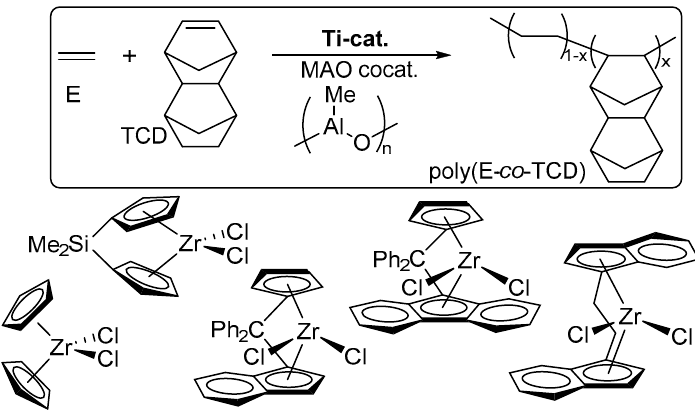
Table 2. Copolymerization of ethylene with tetracyclododecene (TCD) by Cp’TiCl 2 (N=C t Bu 2 ) (Cp’ = Cp ( 7 ), t BuC 5 H 4 ( 8 )), CpTiCl 2 [1,3 ‐ t Bu 2 (CHN) 2 C=N] ( 9 ), Me 2 Si(C 5 Me 4 )(N t Bu)]TiCl 2 ( 3 ) ‐ MAO catalysts. a